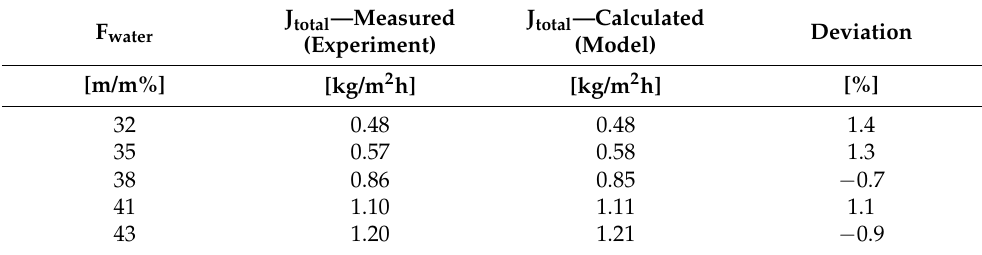
Table 4. Comparison of experimental and model fluxes for laboratory-size separation: model valida- tion. F water